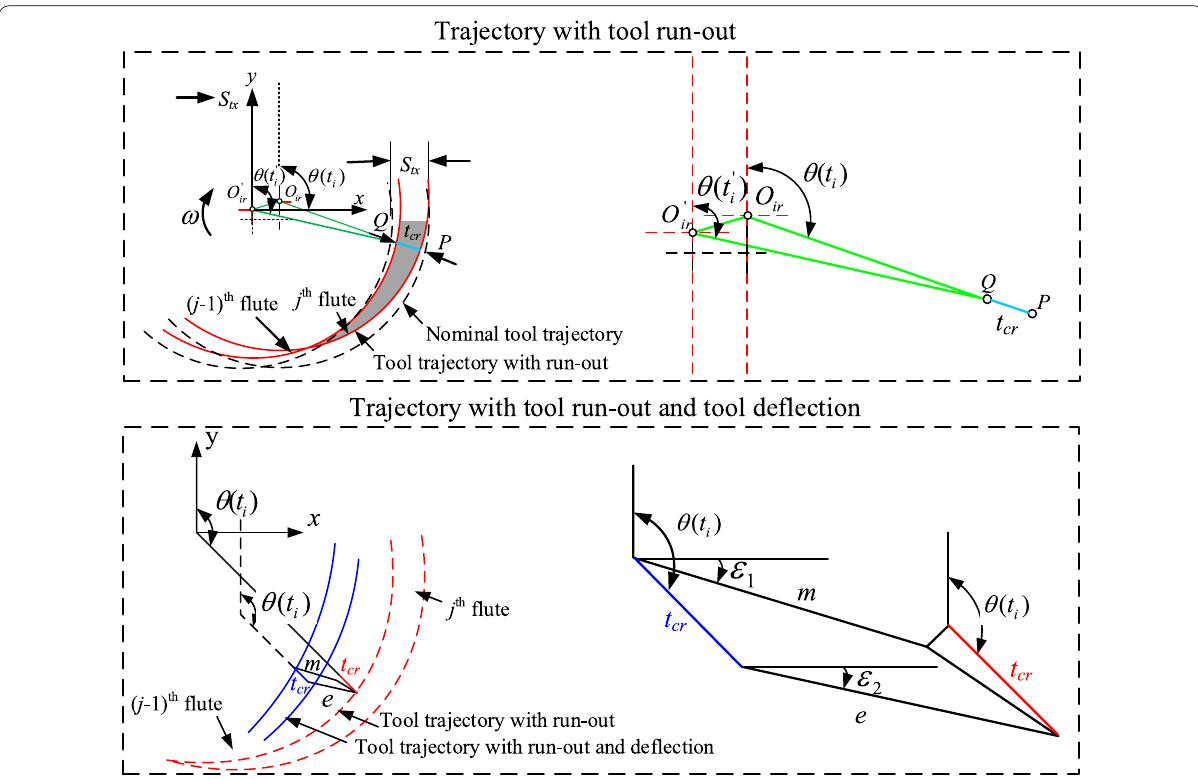
Figure 13 Trajectory of the ( j -1)th and j th flutes in micro-end-milling